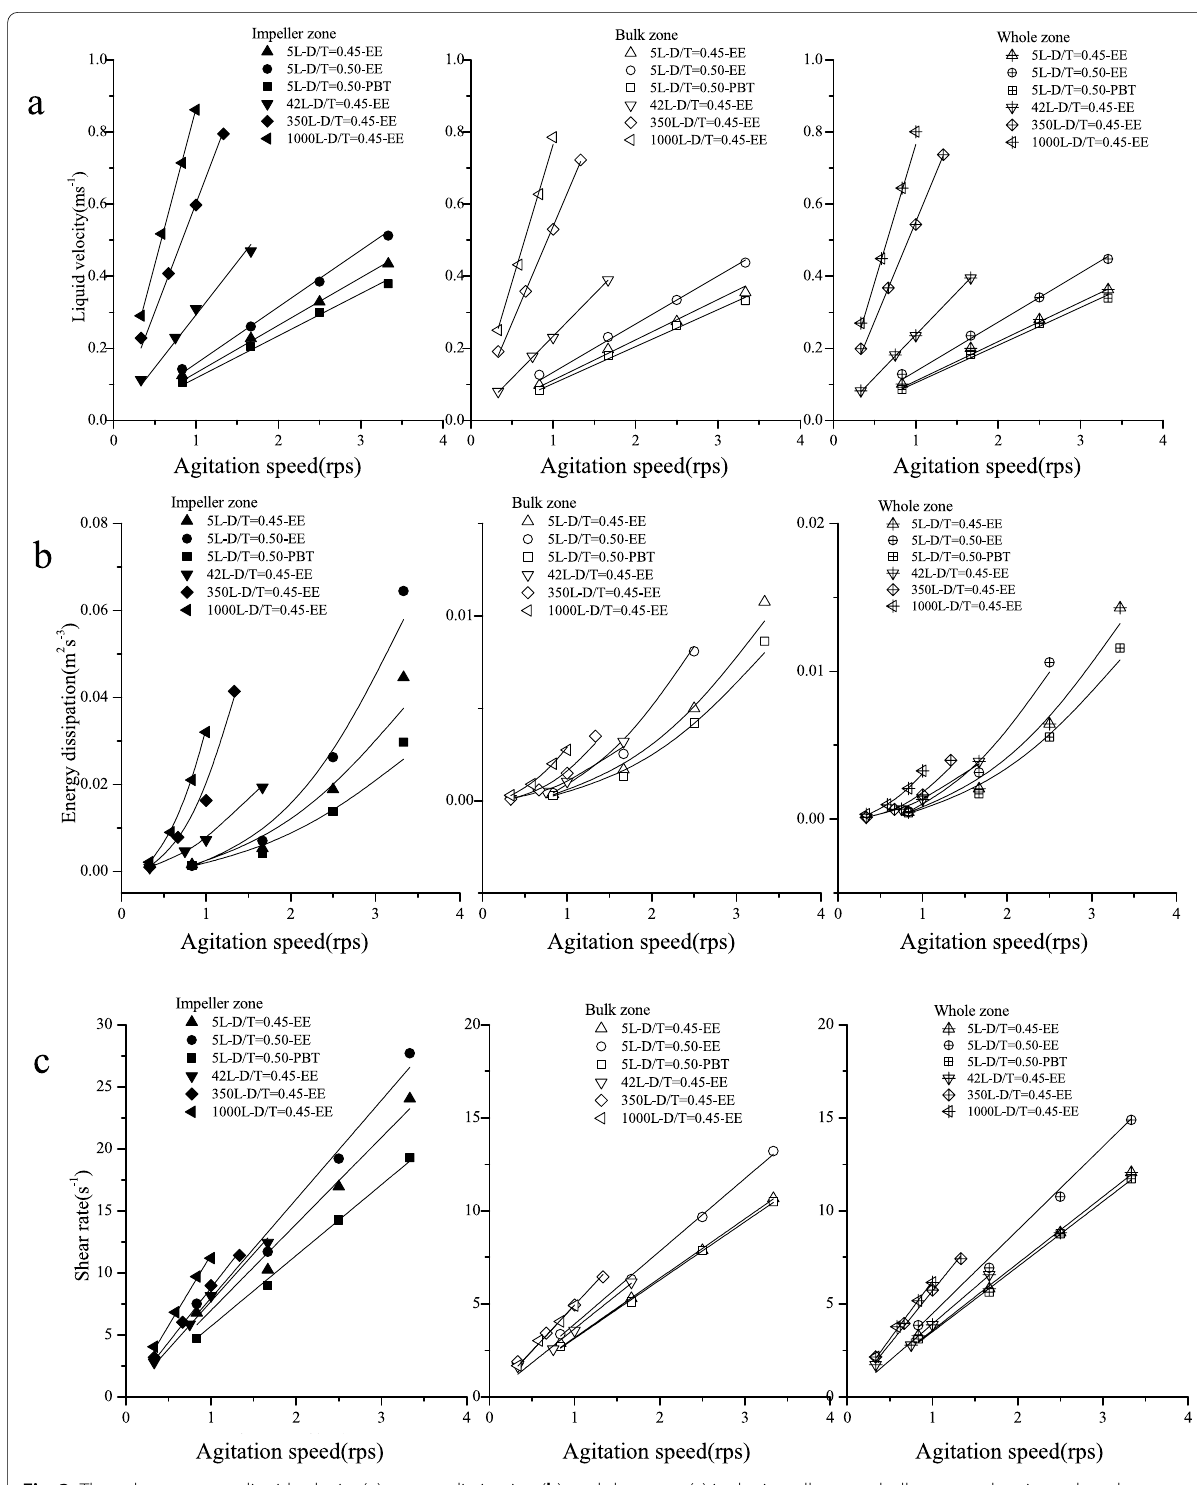
Fig. 3 The volume average liquid velocity ( a ), energy dissipation ( b ), and shear rate ( c ) in the impeller zone, bulk zone, and entire tank under different agitation